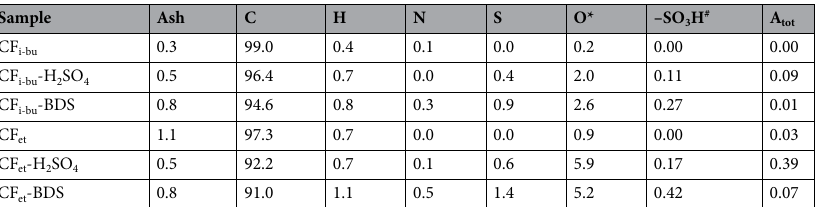
Table 1. Results of the elemental analysis (wt.%), total acidity measurements (A tot , mmol H + /g), sulfonic groups (–SO 3 H, mmol/g) and ash content determinations for the obtained samples. *Calculated by difference; # calculated from the elemental